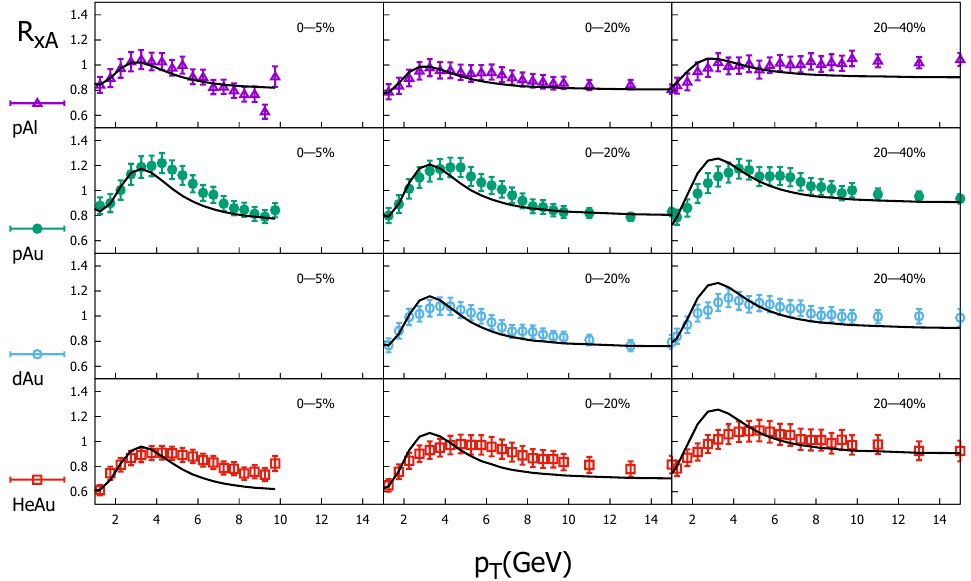
Figure 1. The nuclear modification factor, R xA ( p T ) , computed using Equations (6)–(9), with inclusion of thermal effects and comparison to data from PHENIX Collaboration [30]. Different projectile species and three more central classes of centrality are